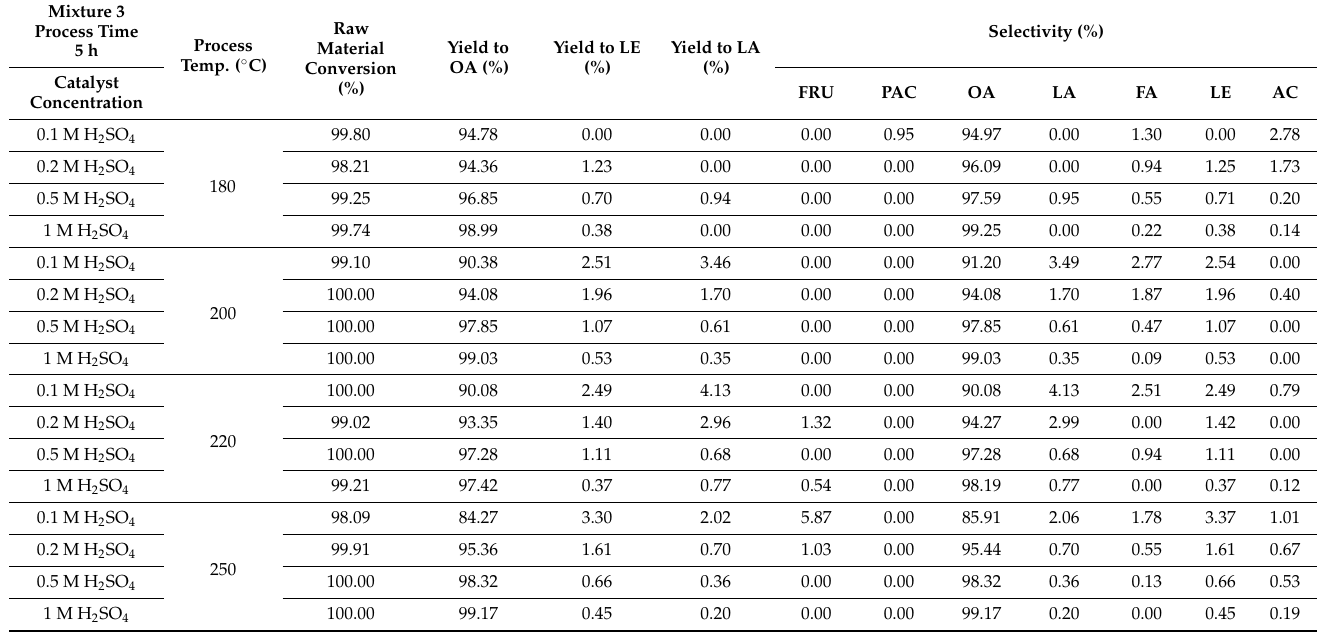
Table 6. The results of HPLC analysis for the catalytic conversion of hemicellulose carbohydrates using the homogeneous H 2 SO 4 catalyst in the liquid phase, with a 5 h process time for mixture 3.